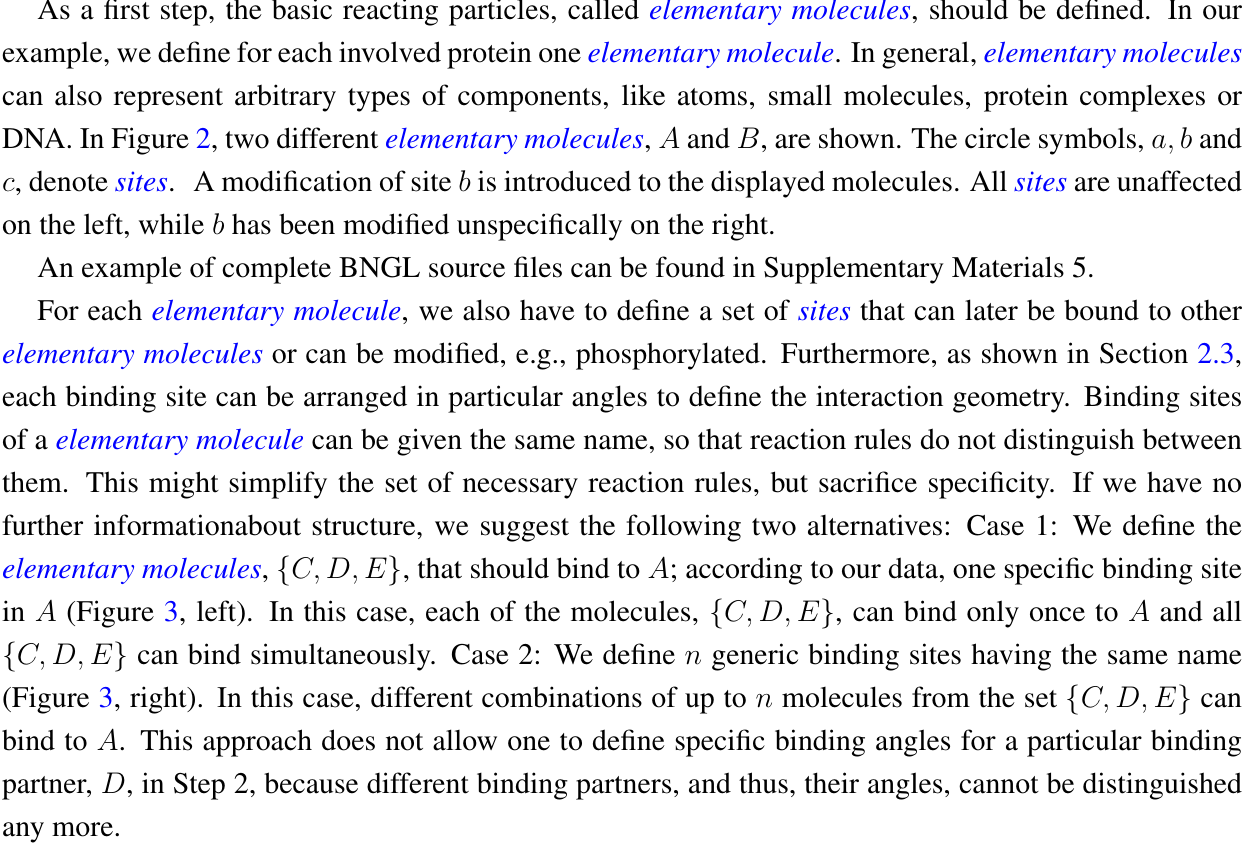
Figure 2. Examples of typical elementary molecules . On the left side, two different elementary molecules , A and B , are displayed with three sites , a , b and c , which are represented by the circles. The attached squares on the right symbolize a modification